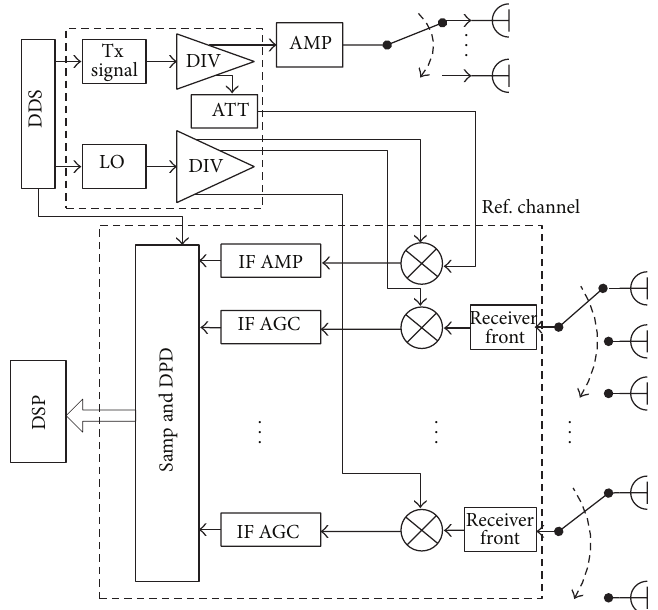
Figure 7: The principle diagram of through-the-wall radar